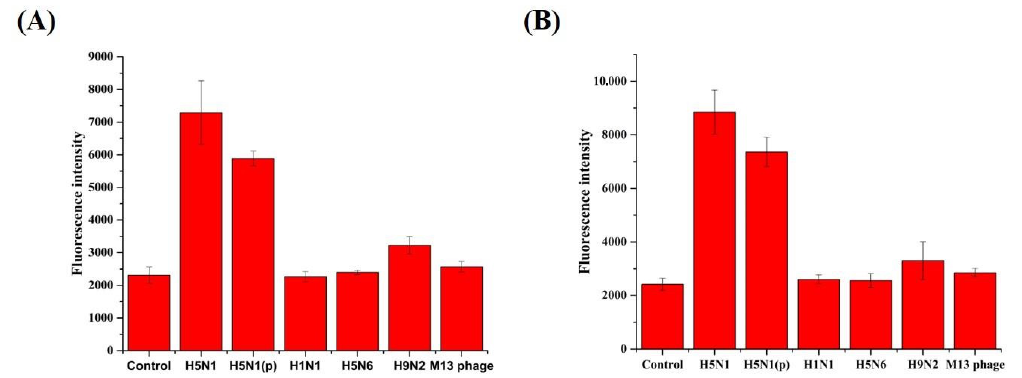
Figure 2. Specificity test for the selected aptamers. Each aptamer (HBA1 ( A ) and HBA2 ( B )) specifically bound to H5N1 and H5N1( p ), which was significantly greater specificity than for other virus subtypes (H1N1, H5N6, and H9N2) and non-influenza virus (M13 phage).